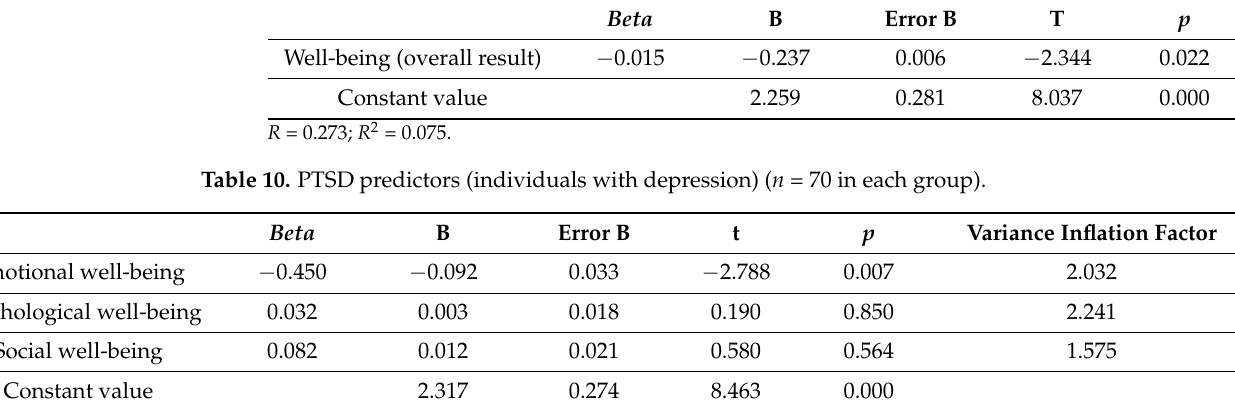
Table 9. PTSD predictors (individuals with depression) ( n = 70 in each group).